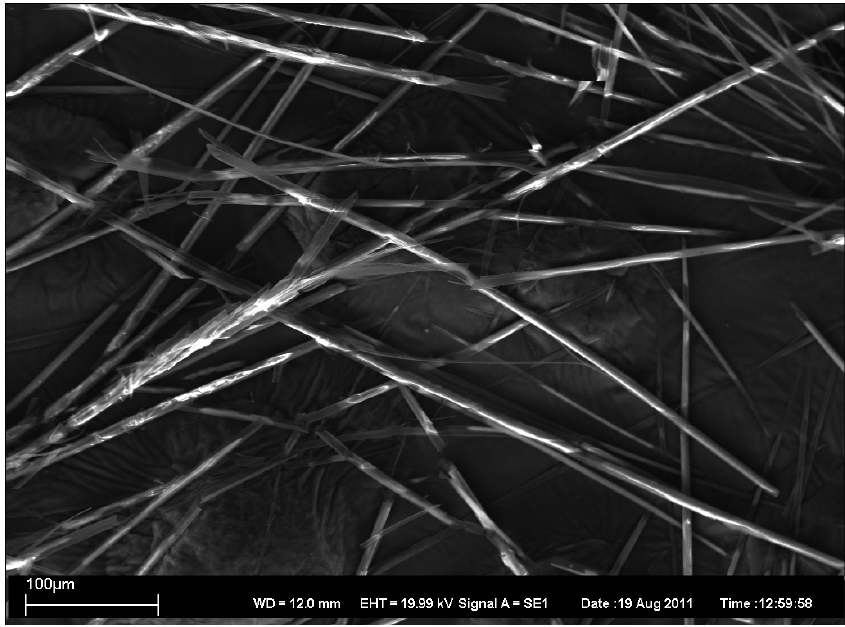
Figure 3. SEM image of xerogel from 2:1 MeOH/water 1% gel.